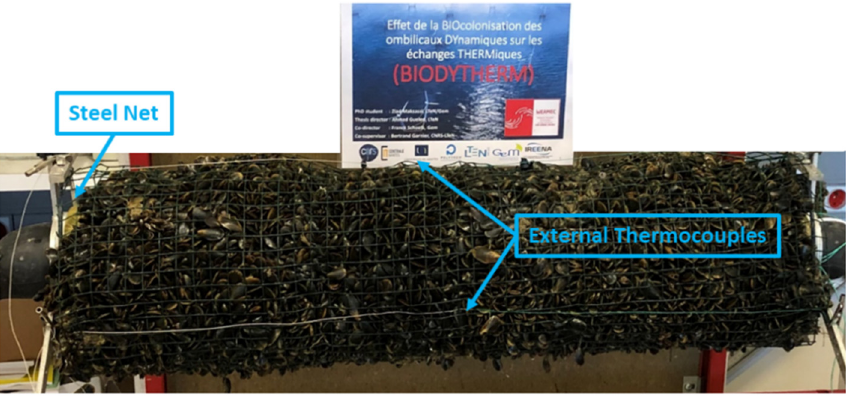
Figure 6. Uniform distribution of mussels around the experimental tube held by a steel net.